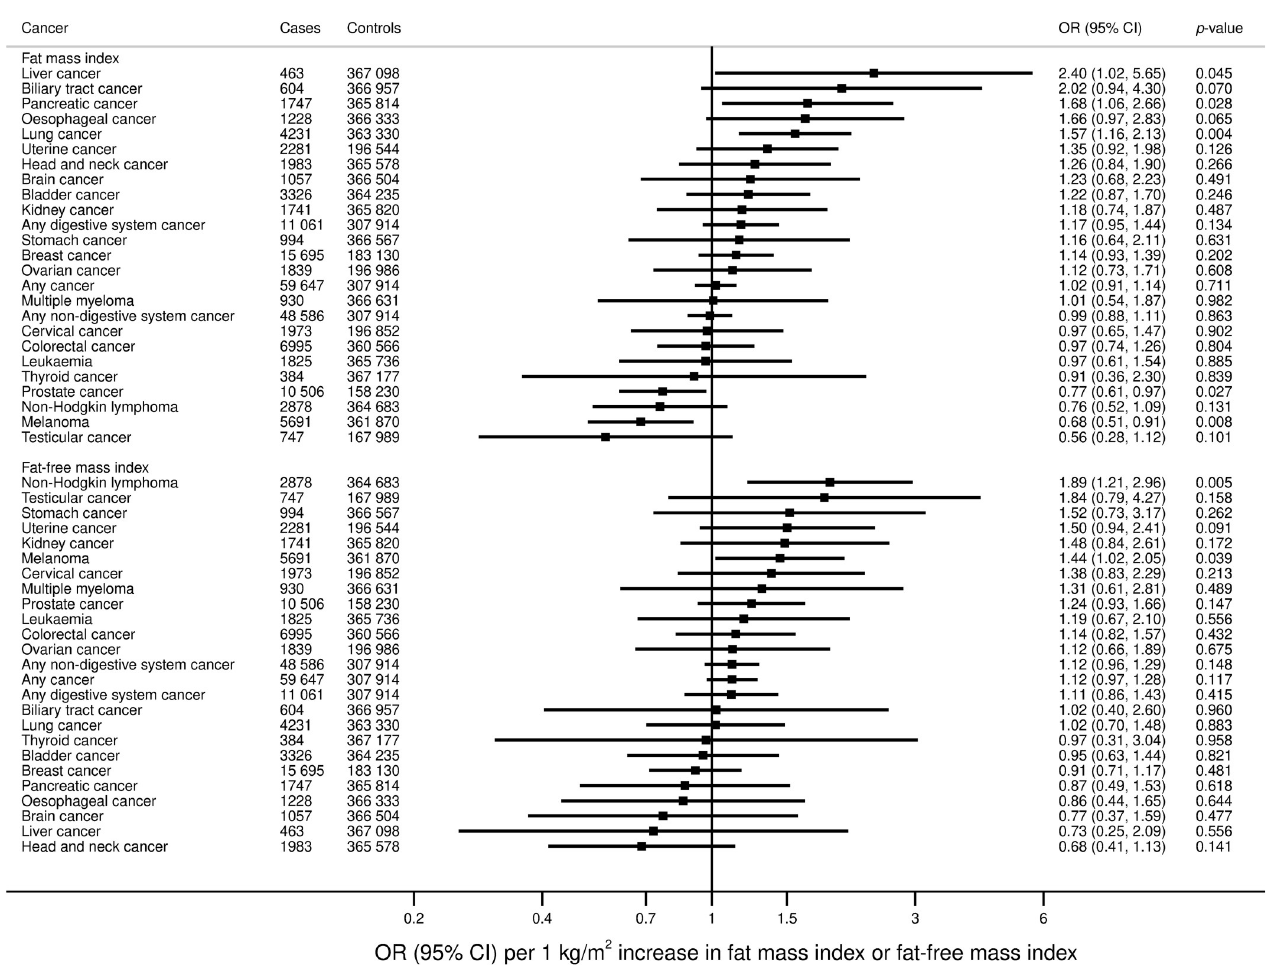
Fig 3. Associations of genetically predicted FMI and FFMI with overall and site-specific cancers in the UKBB. ORs are expressed per one 1 kg/m 2 increase in FMI. Results are obtained from the multivariable random-effects inverse-variance weighted method. CI, confidence interval; FFMI, fat-free mass index; FMI, fat mass index; OR, odds ratio; UKBB, UK